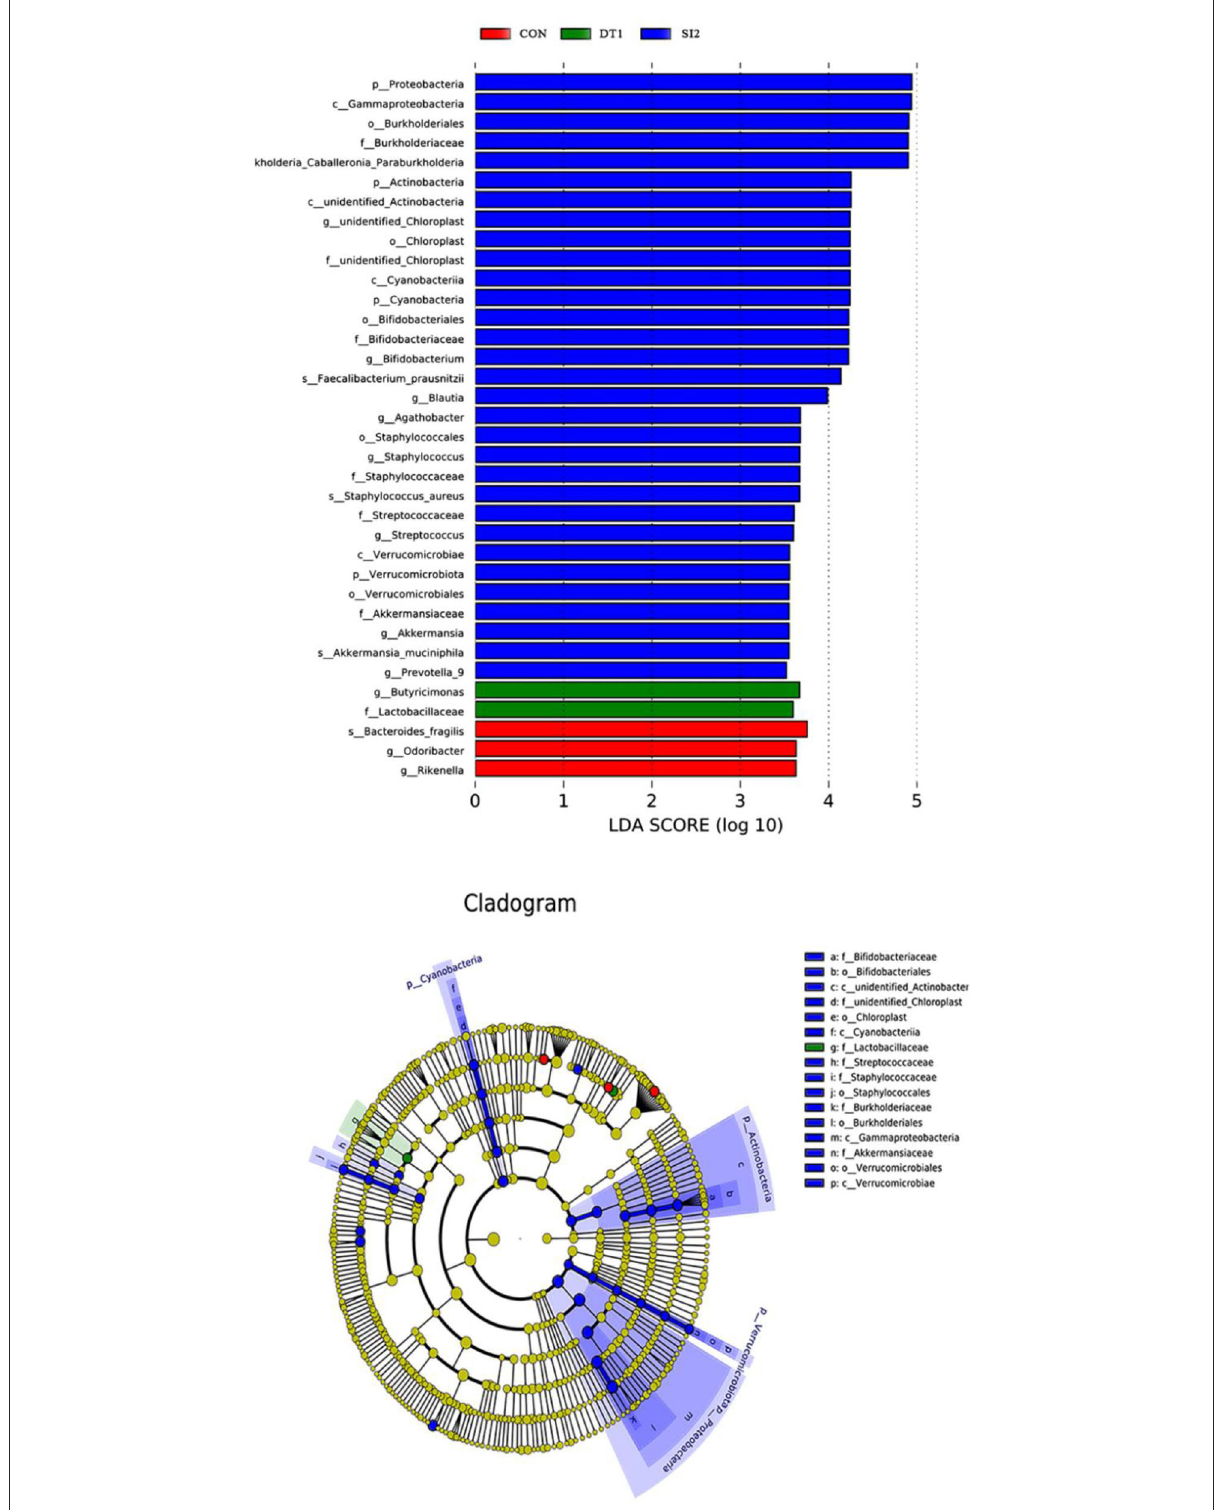
FIGURE8 Linear effect size (LDA) effect size (LEfSe) analysis at the family level with the threshold set to